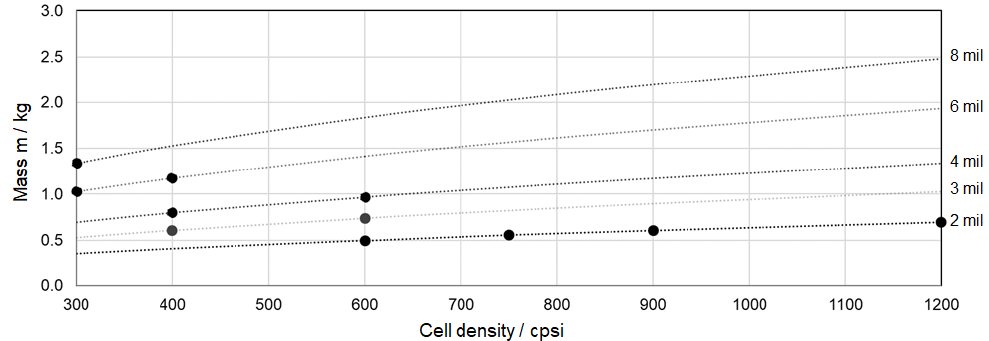
Figure 5. Mass of monoliths with respect to their cell density and wall thickness.